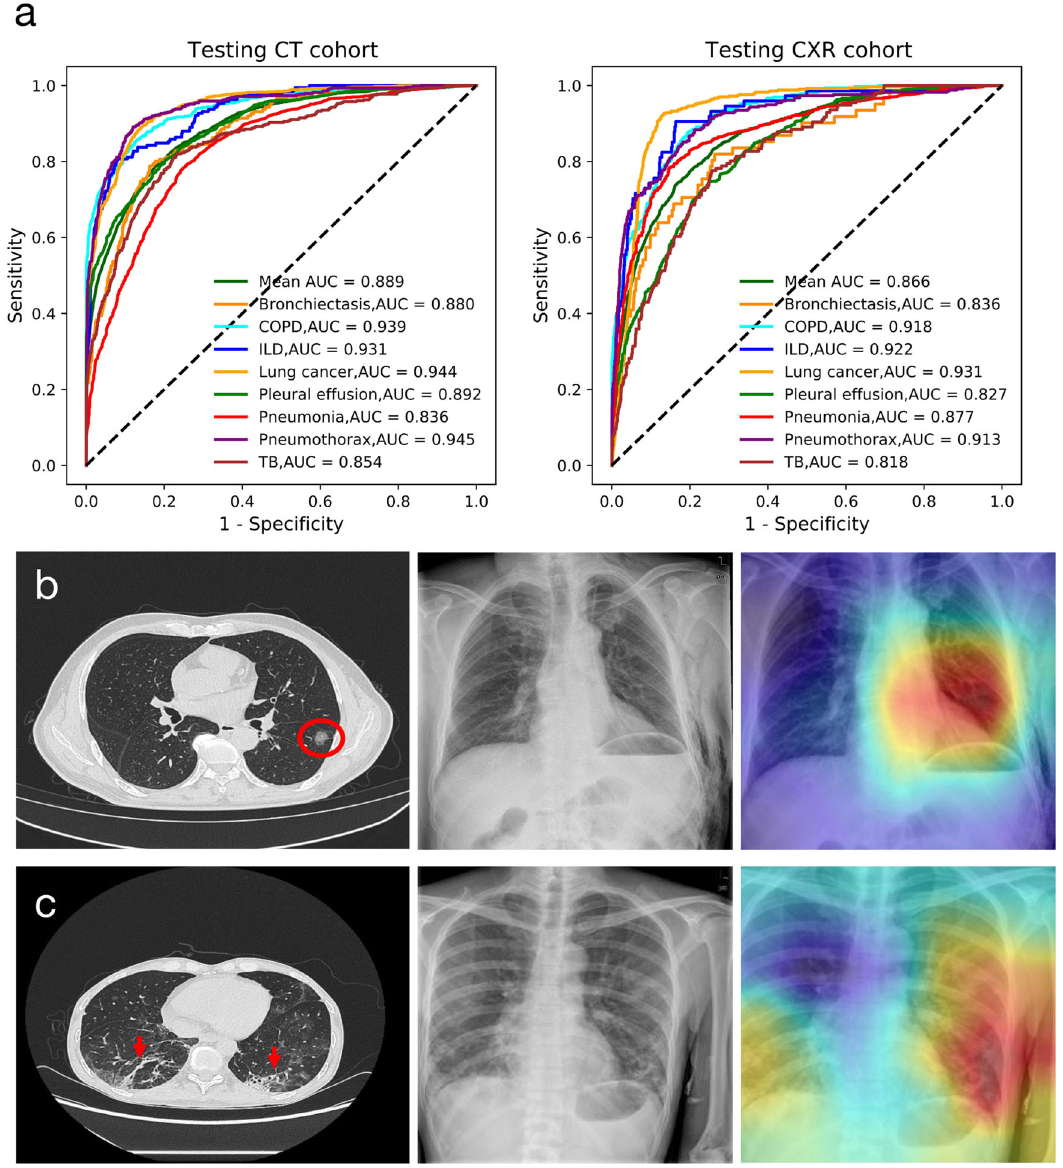
Fig. 3 The relative performance of AI system for the CT and CXR cohorts of the same patients for multi-disease diagnosis. a ROC curves of AI system in making diagnoses of the included eight diseases based on the CT and CXR cohorts. b Patient with lung cancer who had a proper diagnosis by all readers on the CT scan (red circle) but incorrect predictions on the CXR, whereas the AI system could precisely localize the lesion location. c A case with pneumonia where all readers correctly identi fi ed the infectious lesions (red arrows) on the CT scan but made wrong diagnoses based on the CXR images. COPD chronic obstructive pulmonary disease, ILD interstitial lung disease, TB